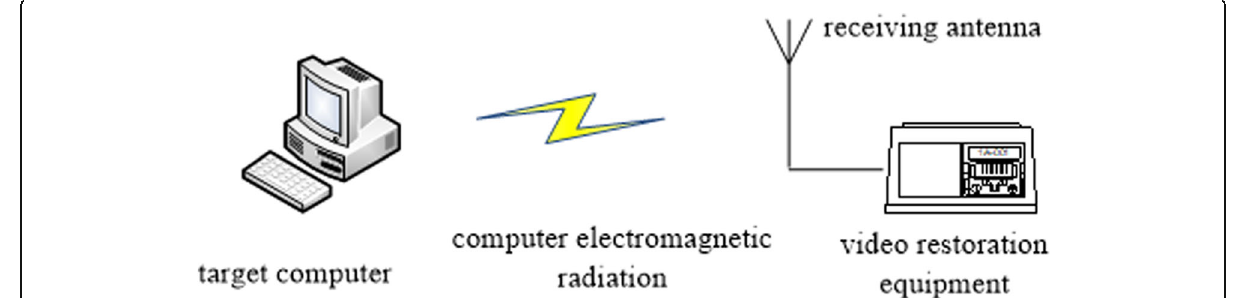
Fig. 1 Diagram of computer video electromagnetic leakage emission